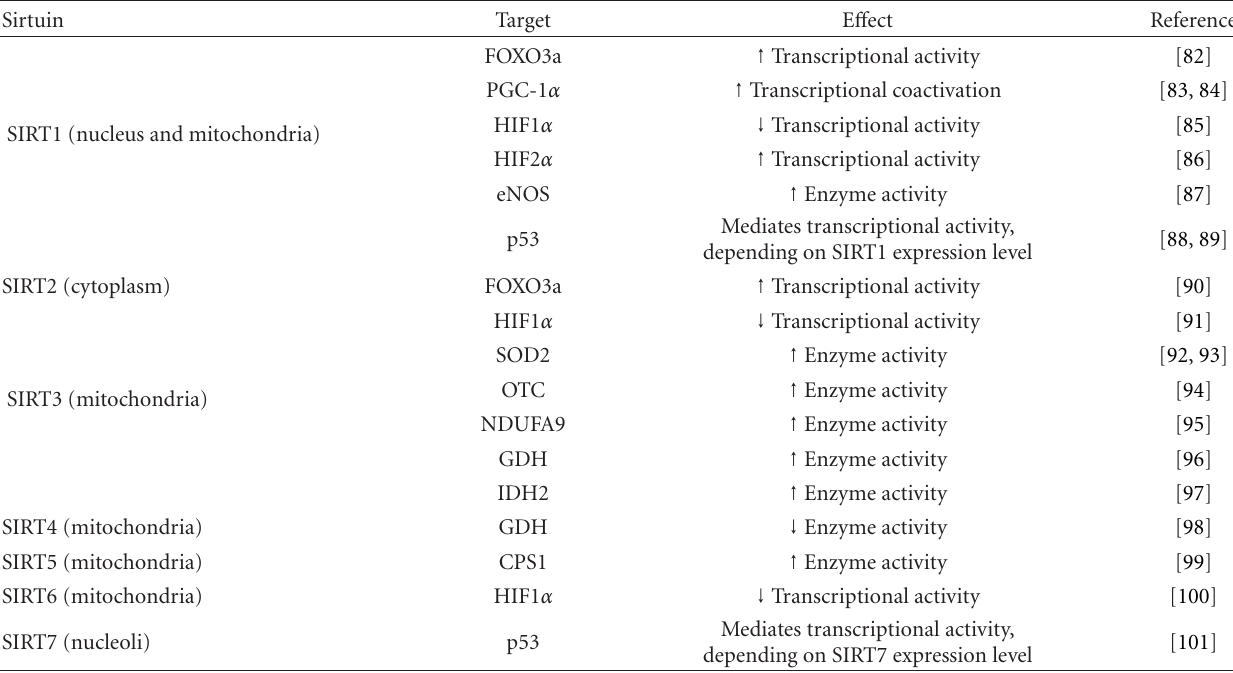
Table 2: E ff ects of class II HDACs (Sirtuins) on redox-related proteins.